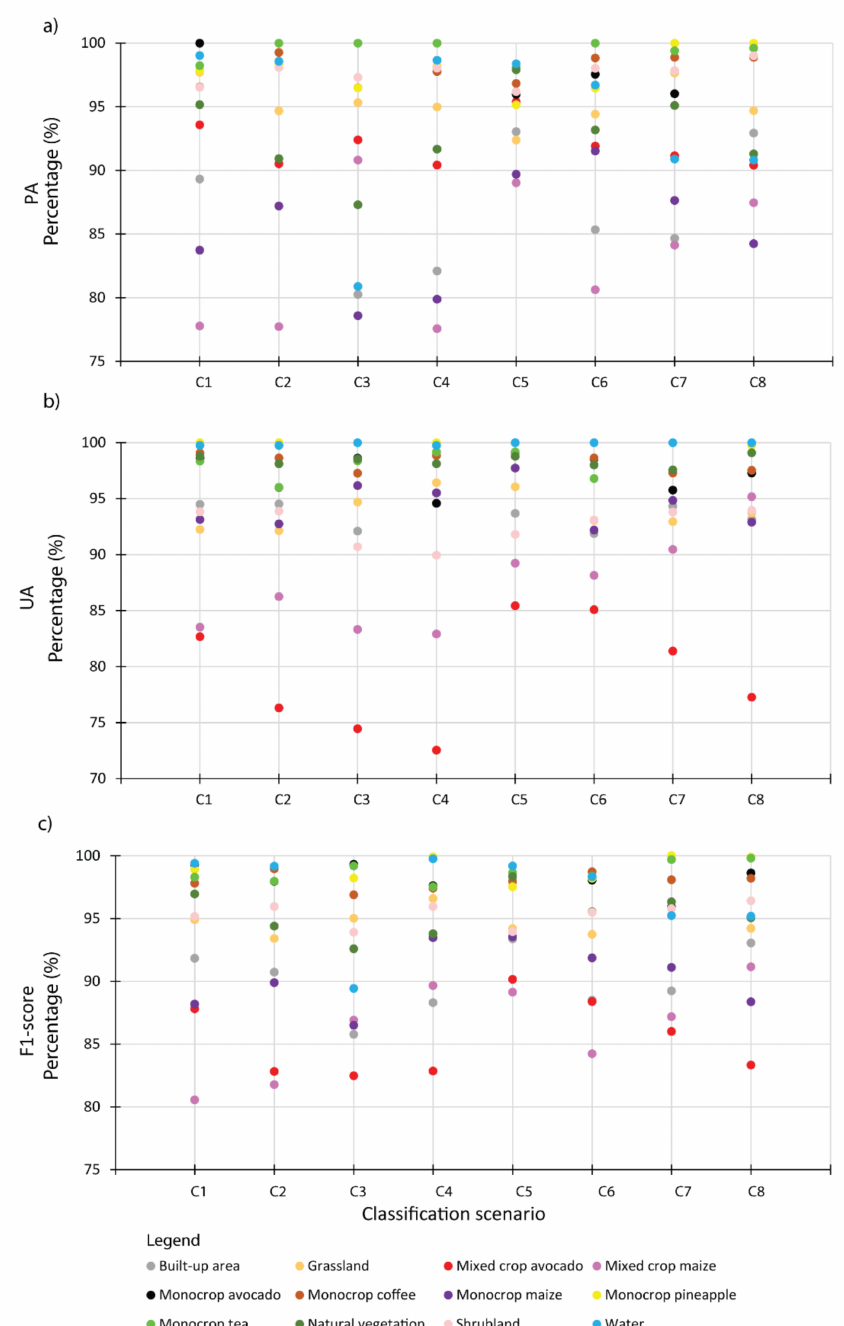
Figure 6. Summarized class-wise accuracies of ( a ) producer’s accuracy (PA), ( b ) user’s accuracy (UA), and ( c ) F1-score using the guided regularized random forest (GRRF)-selected variables of each scenario (C1–C8). C1 = Sentinel-2 reflectance bands, i.e., S2 bands; C2 = S2 bands and vegetation indices (VIs), i.e., S2 bands and VIs; C3 = S2 bands and vegetation phenology (VP), i.e., S2 bands and VP; C4 = S2 bands and Sentinel-1 (S1) backscatter data, i.e., S2 bands and S1; C5 = S2 bands, VIs and S1; C6 = S2 bands, VP, and S1; C7 = S2 bands, VIs, and VP; and C8 = S2 bands, VIs, VP and